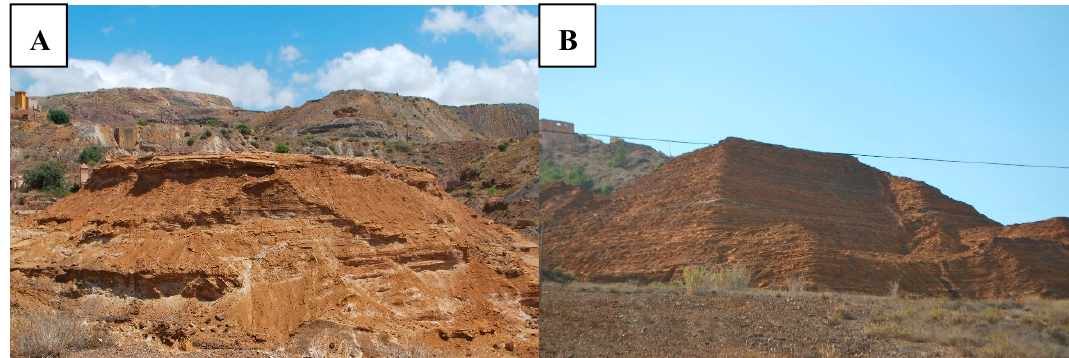
Figure 1. Earth dams in El Avenque ( A ) y El Descargador ( B